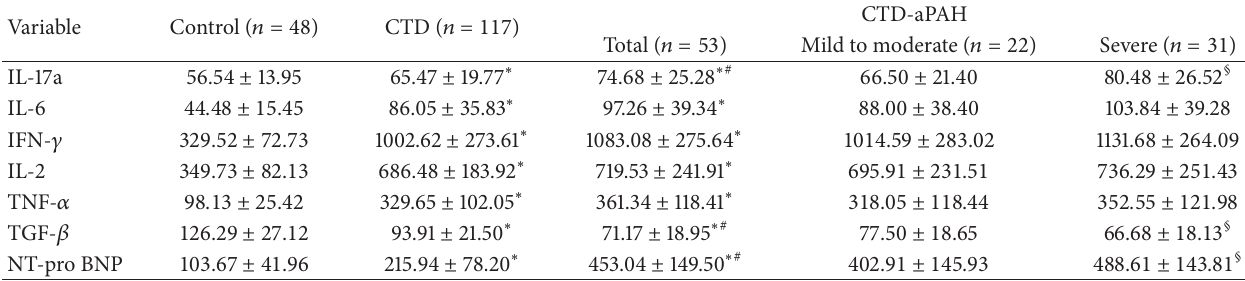
Table 2: Concentrations of serum cytokines and NT-proBNP determined by radioimmunoassay or Elecsys NT-proBNP sandwich immunoassay